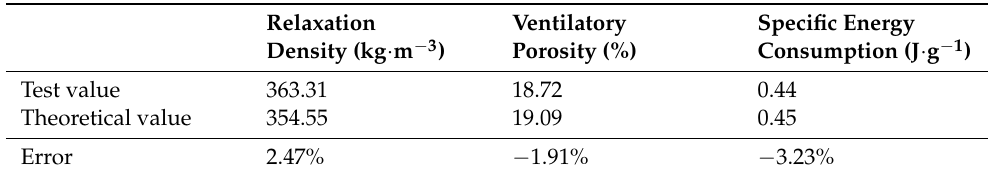
Table 6. Prediction and test results of rabbit manure compost seedling nursery blocks optimized with ventilatory porosity as the